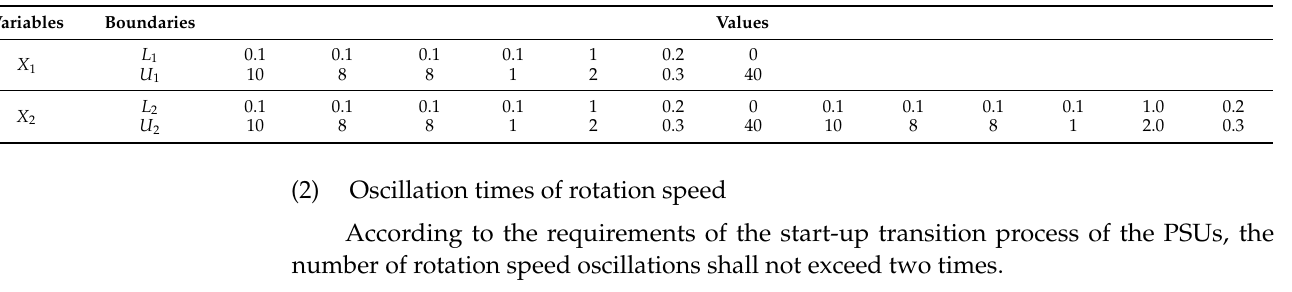
Table 3. The boundaries of the optimization